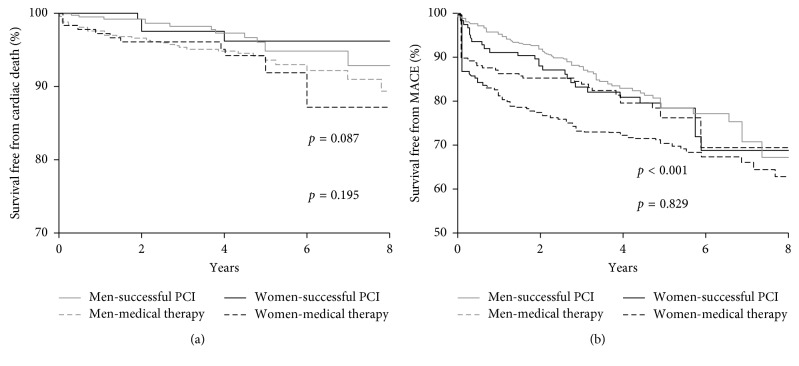
Kaplan–Meier curves for cardiac death (a) and MACE (b) during follow-up for successful CTO-PCI versus medical therapy in male and female patients. CTO, chronic total occlusion; MACE, major adverse cardiovascular events; PCI, percutaneous coronary intervention.